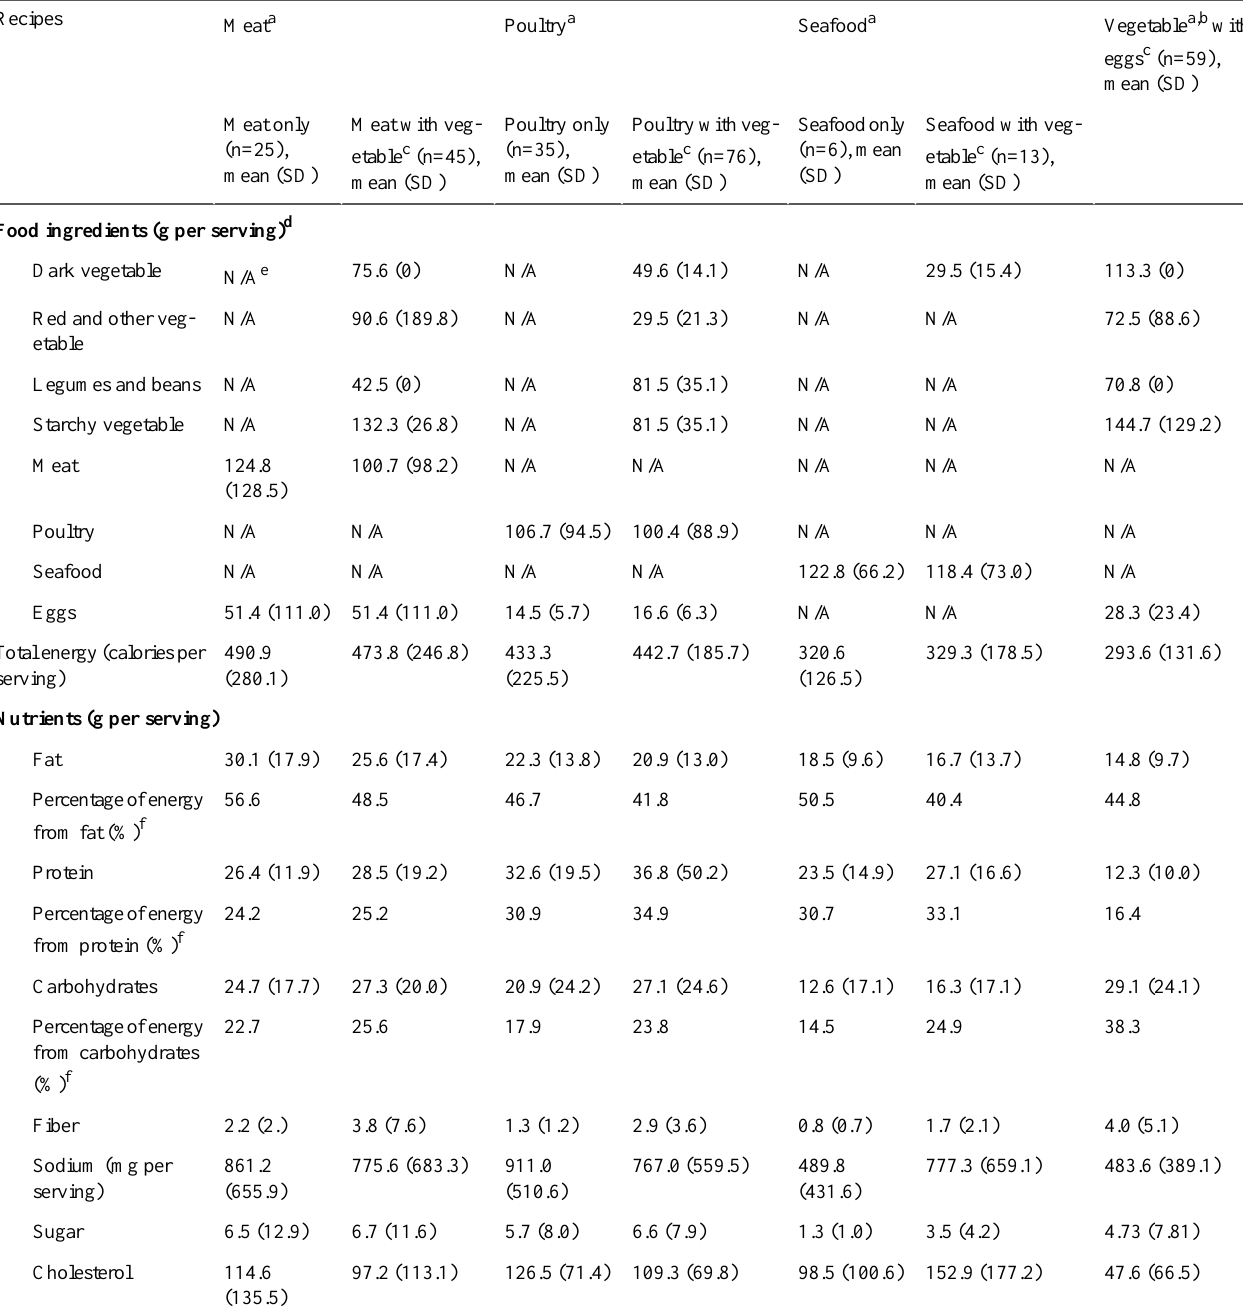
Table 1. The ingredient and nutrient distributions of meat, poultry, seafood, and vegetable recipes.